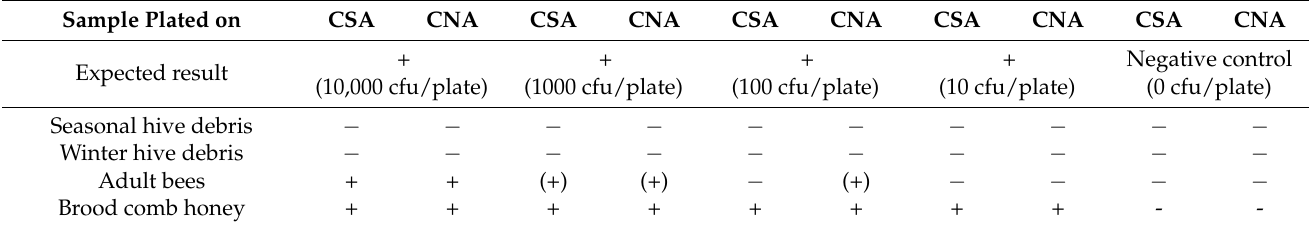
Table 1. Detection of P. larvae in different matrices spiked with varying numbers of P. larvae spores and plated on CSA or CNA culture